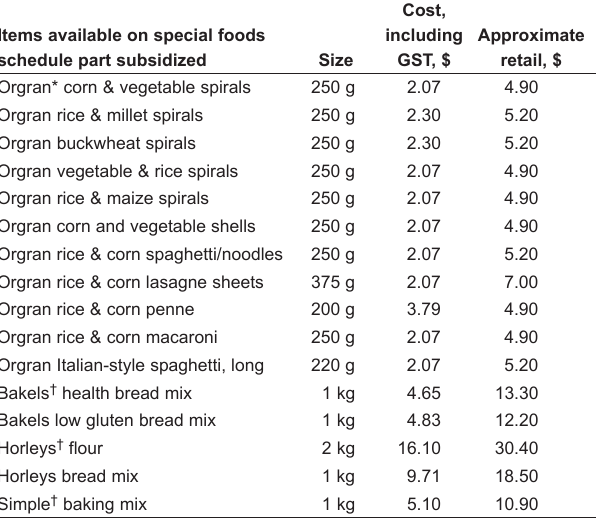
TABLE 3 Example of gluten-free products coverage through